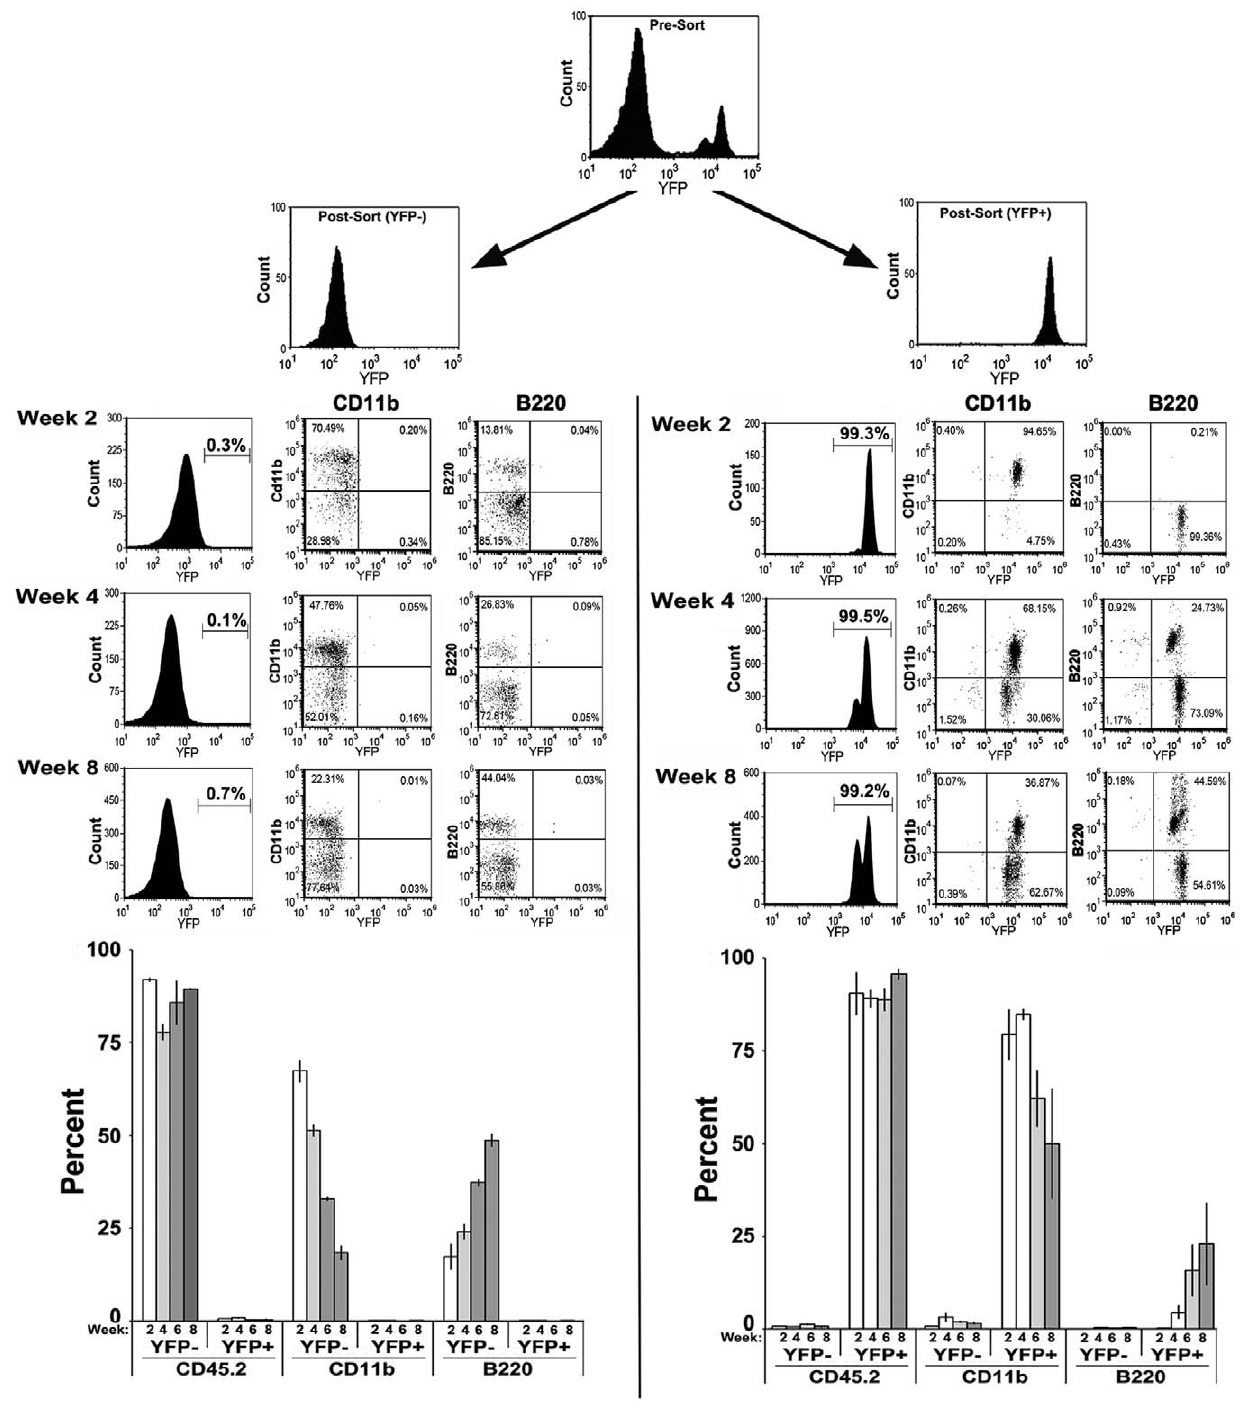
Figure 4. Cell sorting of a 7 lin– and a 7 lin + cells from a 7 Cre:YFP mice followed by injection into lethally irradiated recipient mice results in mice reconstitution by the respective donor population. (A) Bone marrow cells from a 7 Cre:YFP mice (CD45.2 allele) were dissociated and YFP expression determined by FC. The distribution of a 7 lin + versus a 7 lin– cells prior to sorting is shown in the top panel (pre-sort). Following sorting for a 7 lin + (YFP + ) or a 7 lin– (YFP - ) cells as described in Methods, a sample of cells was analyzed post-sorting as is shown in the left panel a 7 lin– (YFP - ) and the right panel a 7 lin + (YFP + ). Lethally irradiated recipient mice (CD45.1 allele) were injected with 2 6 10 6 of the CD45.2/ a 7 lin– or the CD45.2/ a 7 lin + sorted cells. Mice were monitored via small blood samples for CD45.2 allele to indicate donor specific lineage of cells having cell-type specific markers (e.g., CD11b, B220). Results have been repeated at least 3 times using groups of 4 mice each and these data quantified as shown in the bottom bar graphs (mean + / 2 s.e.m.). Supplemental data (Supplemental Figure 2) provides a more extensive marker analysis for this experiment including GR1, CD11b, B220, CD8, CD45.1 and CD45.2.